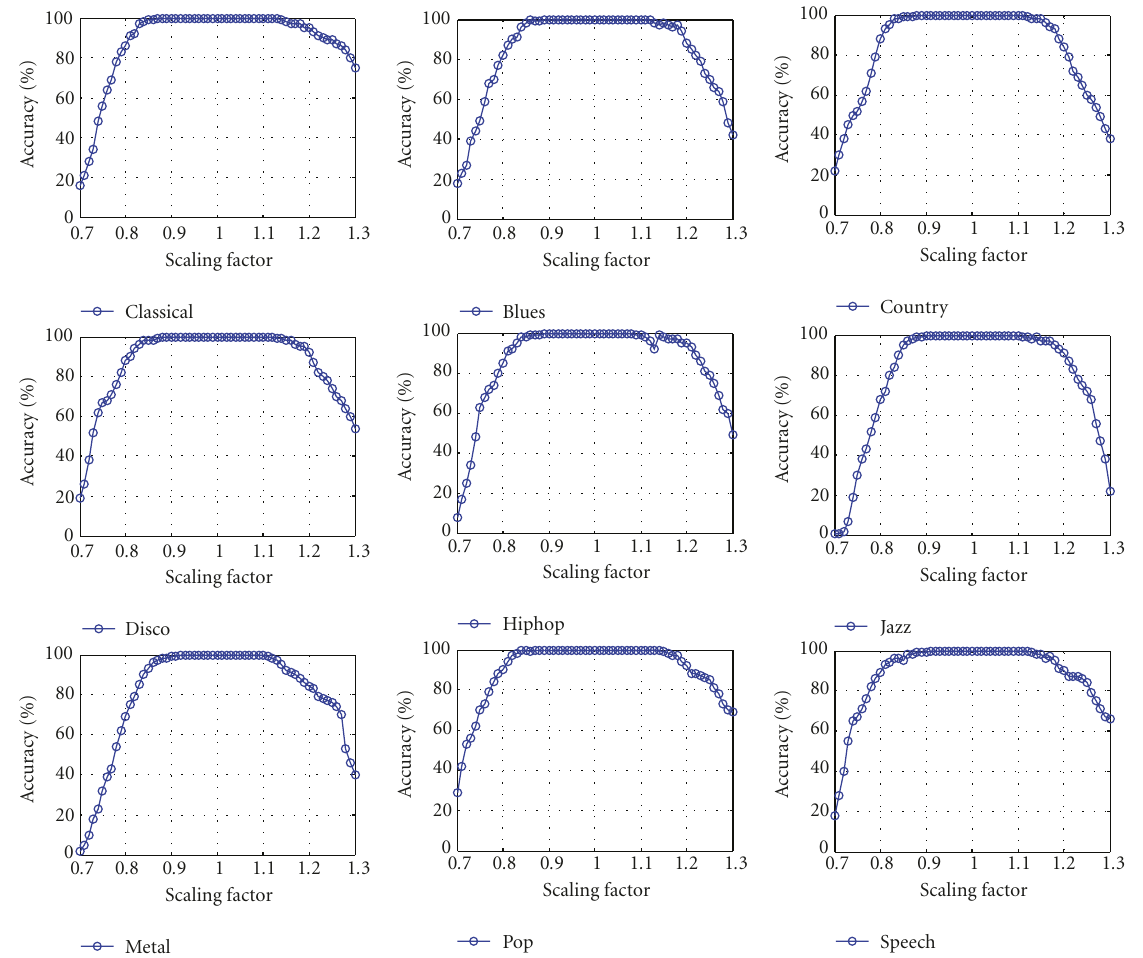
Figure 10: Robustness against linear